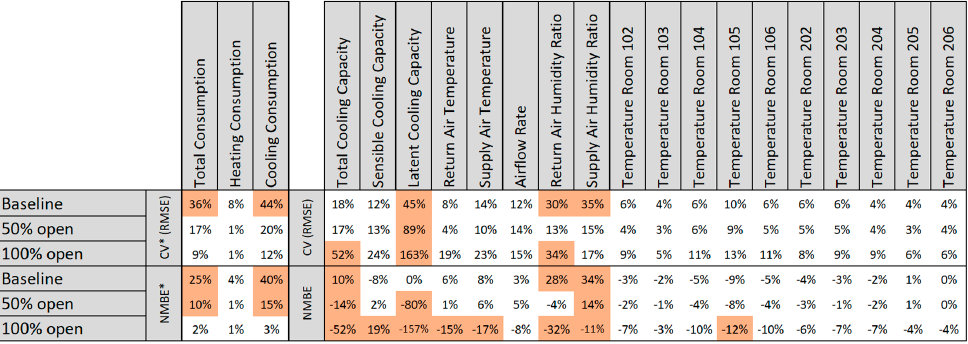
Table 11. CV (RMSE) and NMBE calculations for detailed model outputs: Economizer opening stuck at a fixed